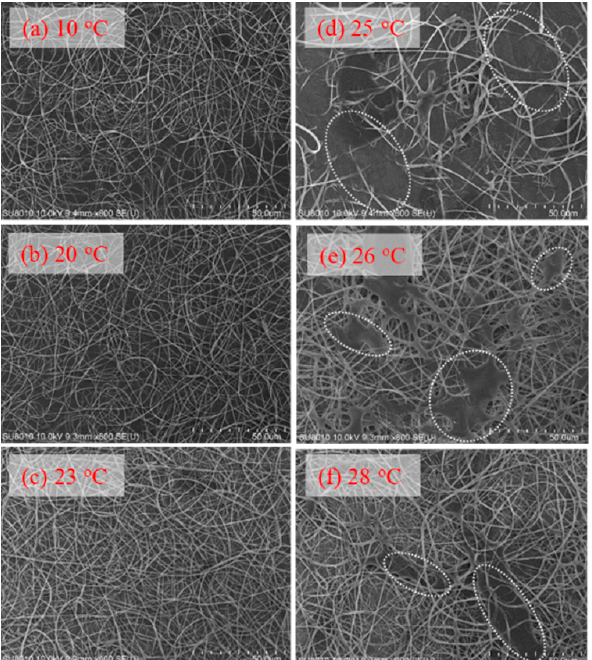
Figure 16. Effect of solution temperature on the fiber morphology collected on the grounded collector ( a – f ). In ( d – f ), the white dotted regions indicate the area where the detaching droplets splashed onto the nanofiber fabrics.